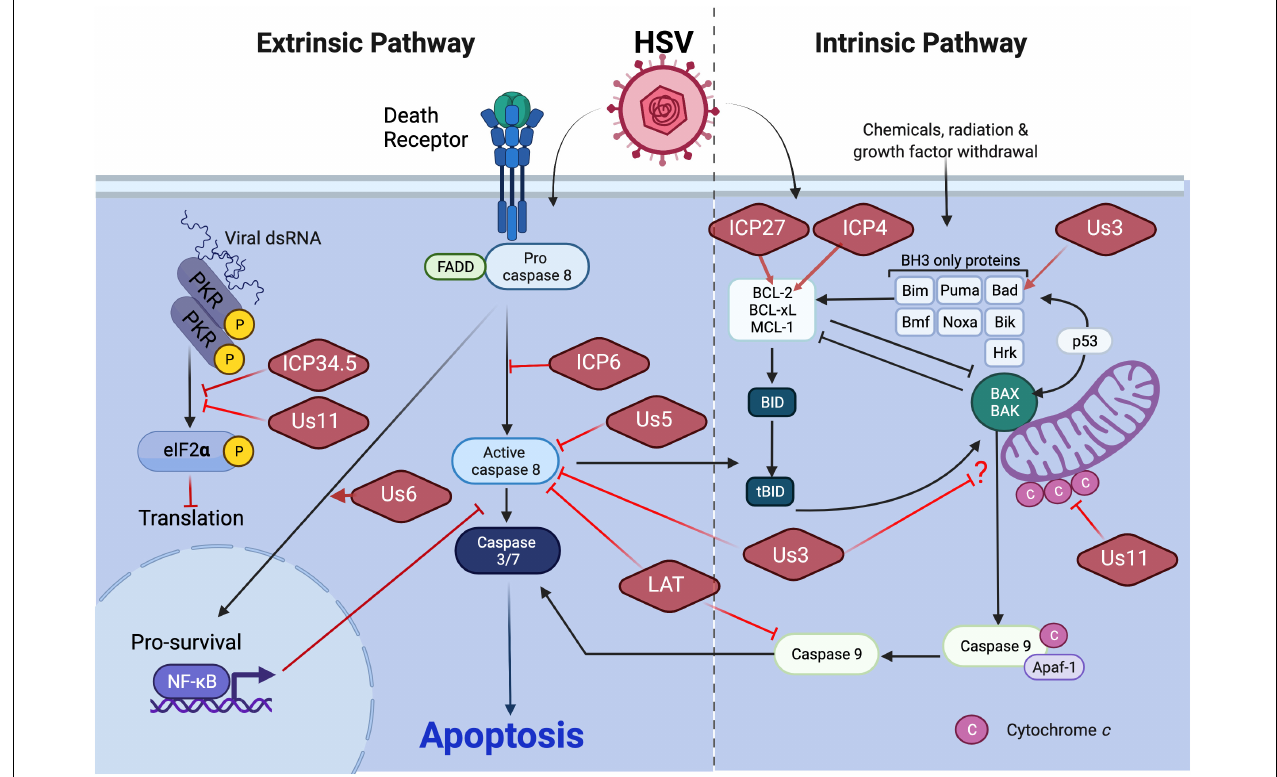
FIGURE 1 | HSV1 manipulation of apoptosis. Execution of apoptosis restricts HSV1 replication and dissemination. The extrinsic and intrinsic apoptosis pathways differ with respect to the nature of the death signal as well as initiator caspase (see text). HSV1 encodes an array of anti-apoptotic viral proteins to counteract apoptotic pathways. Virus-encoded ICP34.5 or Us11 limits the extrinsic apoptosis pathway by restricting dsRNA sensing pathways that would lead to activation of apoptosis through inhibition of protein translation. Virus-encoded ICP6 or Us5 block extrinsic apoptosis by preventing caspase 8 activation. Virus-encoded Us6 promotes NF-kB-dependent pro-survival signaling. Virus-encoded Us3 blocks both extrinsic and intrinsic apoptosis through interference with caspase 8 activity and an unknown step in mitochondrial death signaling, respectively. Us3 has also been shown to promote the expression of Bad to limit intrinsic apoptosis as does Us11 through restriction of cytochrome c release from mitochondria. Expression of the pro-survival BCL-2 gene of the intrinsic pathway also has been shown to be stimulated by virus-encoded ICP27 or ICP4. Finally, LAT manipulates the activation of both the extrinsic and intrinsic apoptosis pathways specifically within the central nervous system by blocking inducer caspases 8 and caspase 9,